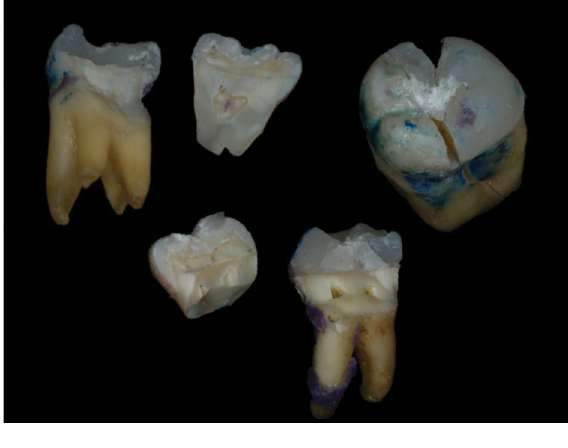
Figure 3. Illustrative images of specimens with severe root and crown fractures classified as non-restorable (Type IV).